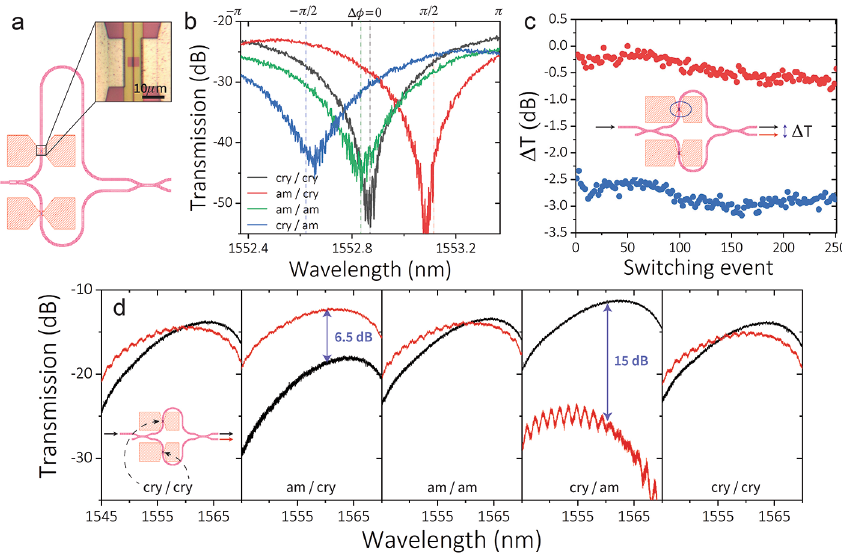
Fig. 2 Sb 2 Se 3 -based phase shifters in balanced (2 × 2 switch) and unbalanced MZI devices. a Layout of an unbal- anced MZI with an optical microscope image of a 6 μm Sb 2 Se 3 cell on a 10 μm-long microheater. b Experimental demonstration of four interferograms corresponding to each phase state permutation in the device shown in a . Crystallization was achieved using 6.2 V [3.2 V] and 1 ms pulses. Amorphization was achieved with 21 V [10.8 V] and 400 ns pulses. Extinction ratio over 35 dB is achieved between opposite states with a nearly complete π phase shift modulation. c Reversible switching over 125 full cycles between two intermediate Sb 2 Se 3 states of the top-arm phase shifter in a balanced MZI. The plotted changes in transmission correspond to the difference between each arm’s intensity. d MZI 2 × 2 switch in the four different permutations: amorphous and crystalline states of each arm’s phase shifter with 6 μm Sb 2 Se 3 cell for π/2 shift. Reversible switching is demonstrated for both cells. The Gaussian- like transmission curves result from the use of grating